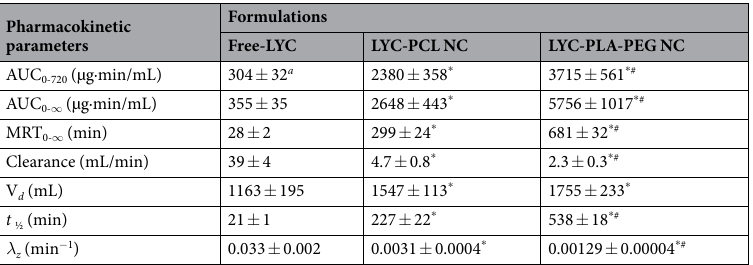
Table 2. Lychnopholide (LYC) pharmacokinetic parameters following intravenous ( bolus ) administration of different nanocapsule (NC) formulations. a AUC 0-60 ( µ g·min/mL) for free-LYC. Dose 12,600 µ g/kg mouse bodyweight. MRT: mean residence time; V d : volume of distribution; t ½ : plasma half-life. λ z : elimination constant. Terminal elimination slope was calculated based on the last three data points. * p < 0.05 compared to free LYC; # p < 0.05 compared to LYC-PCL